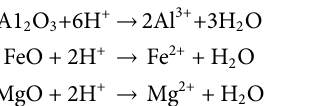
Frontiers in Chemistry |